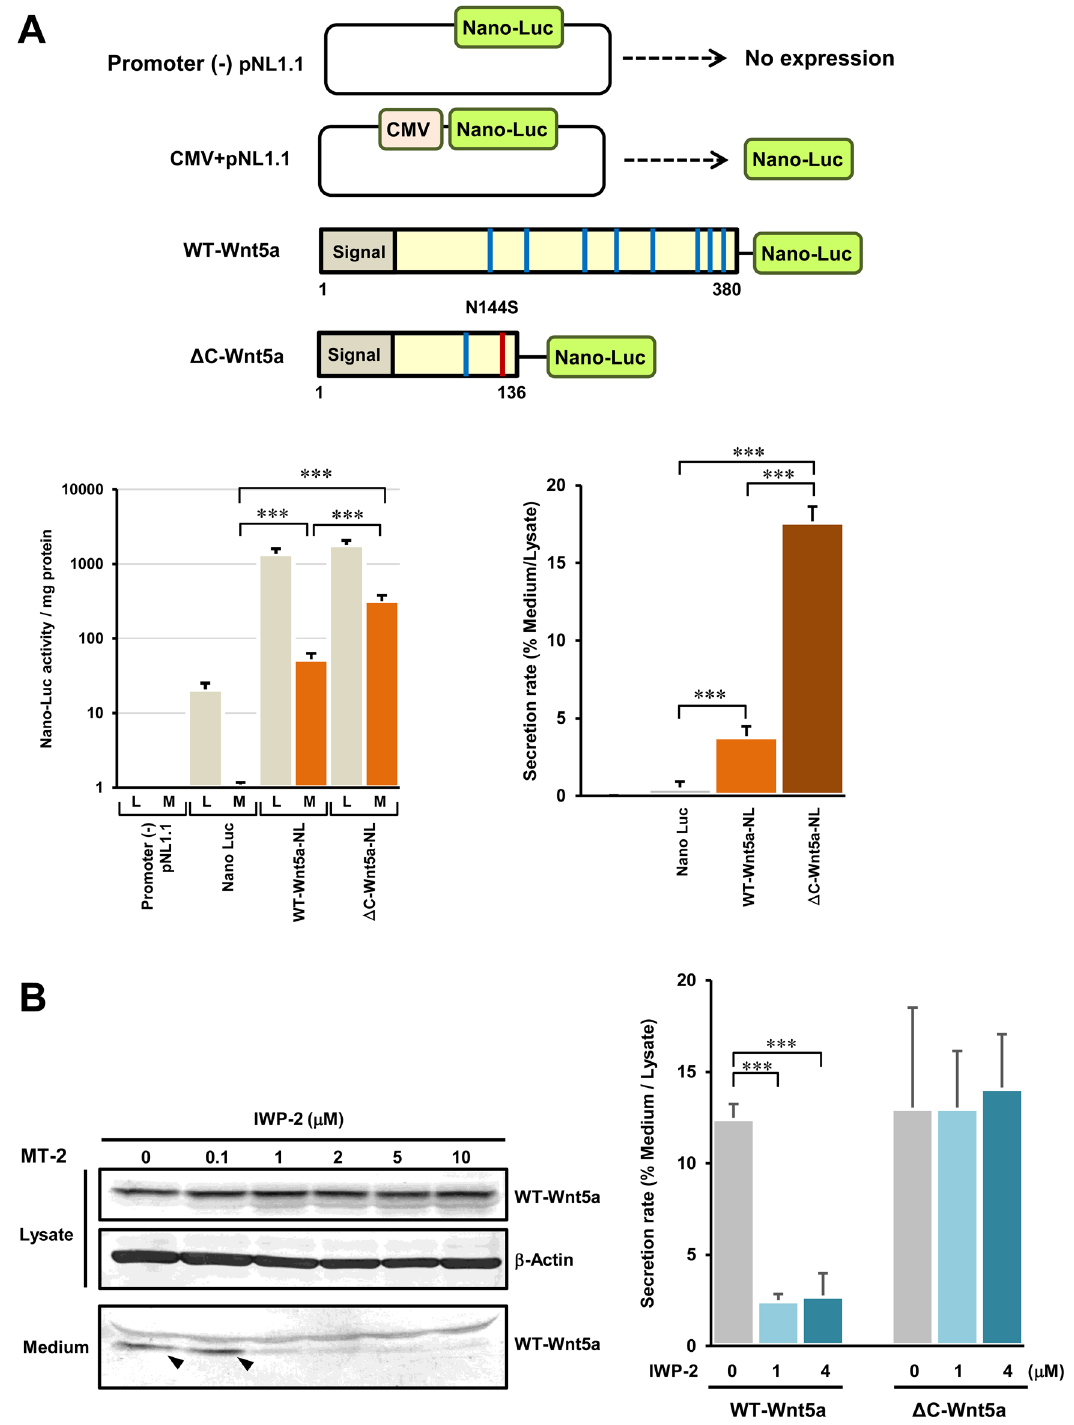
Figure 5. The ΔC-Wnt5a is secreted via a non-canonical secretion pathway. ( A ) In order to test if the ΔC-Wnt5a is secreted out of the cell, we design an assay using Wnt5a fused with NanoLuc at C-terminal (the upper panel). The NanoLuc assays were conducted in the whole cell lysate (L) and the culture medium (M) of HEK293FT cells overexpressing Wnt5a-NanoLuc (the lower left-and side graph, n = 4, mean ± SD, *** P < 0.001), and the secretion rate was calculated as (NanoLuc signal in medium/NanoLuc signal in cell lysate) (the lower right-hand side graph, n = 4, mean ± SD, *** P < 0.001). The secretion rate was about 4-times higher in the ΔC-Wnt5a compared with the WT-Wnt5a. ( B ) IWP-2 inhibits the secretion of Wnt family proteins, including Wnt5a. IWP-2 treatments in MT-2 cells reduced the Wnt5a level detected in the culture medium in a dose-dependent manner, which confirmed that IWP-2 indeed inhibited the secretion of Wnt5a in MT-2 cells (the left-hand side panel). Please note that the left-hand side panel consists of three pictures from three separated blots for the WT-Wnt5a and β-Actin in cell lysate and the WT-Wnt5a in culture medium, respectively, which are clearly separated by black frames. The right-hand side graph shows the secretion rates of the WT-Wnt5a and the ΔC-Wnt5a overexpressed in HEK293FT cells, which were treated with IWP-2 of indicated doses (n = 4, Mean ± SD, *** P < 0.001). The IWP-2 treatment reduced the secretion rate of the WT-Wnt5a significantly, while it did not alter the secretion rate of the